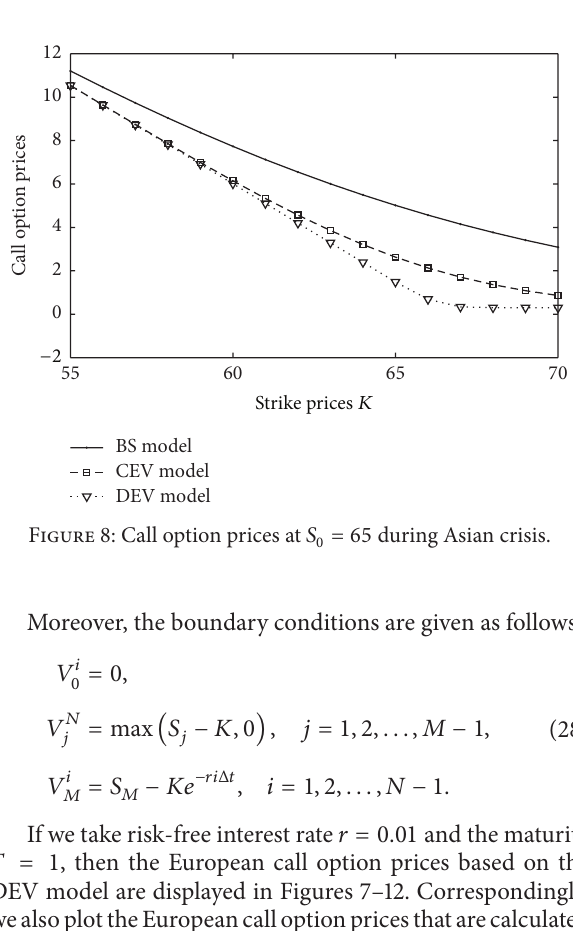
Figure 7: Call option prices at 𝐾 = 53 during Asian crisis.